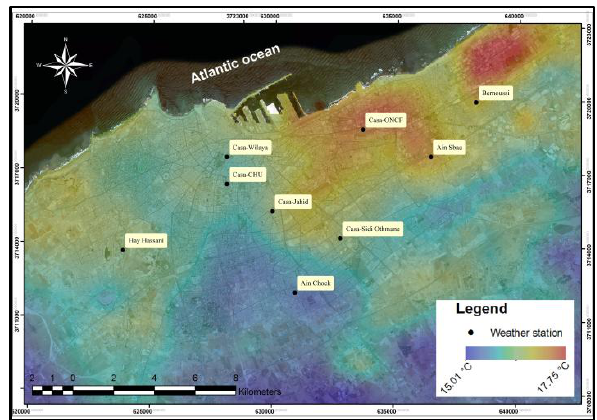
Figure 12. Spatial distribution of maximum air temperature estimated from daytime MODIS observation during the 4th of